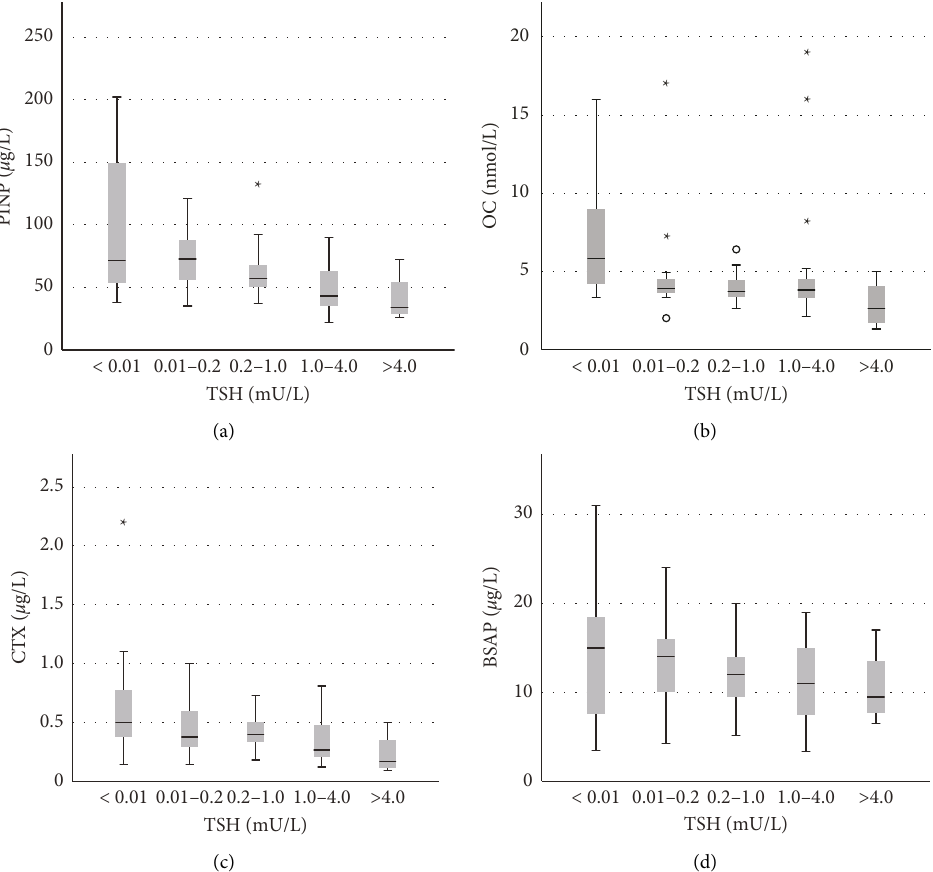
Figure 1: Categorical analysis of the variation in bone turnover markers with TSH. The bone markers investigated were: (a) procollagen type 1 N-terminal propeptide (PINP); (b) osteocalcin (OC); (c) C-terminal cross-linking telopeptide of type 1 collagen (CTX); and (d) bone specific alkaline phosphatase